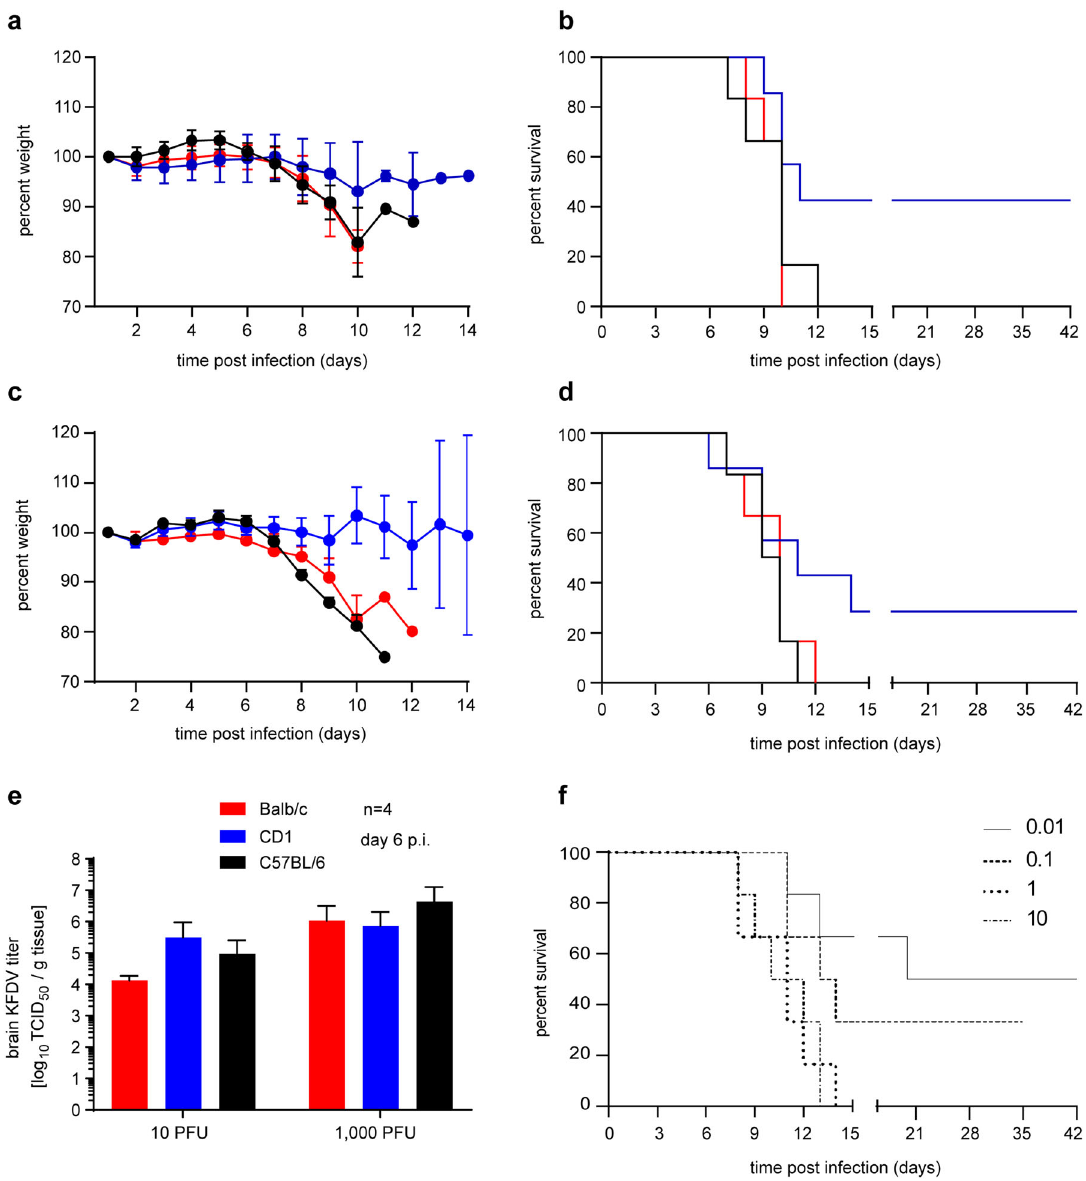
Fig. 2 KFDV infection in immunocompetent mouse strains. Female BALB/c, C57BL/6 and CD1 mice ( n = 10 per group) were inoculated intraperitoneally (IP) with either 10 or 1000 PFU of KFDV. On 6 dpi, 4 mice from each group were euthanized for sample collection. Brain tissue was homogenized and analyzed for infectious titers by a TCID 50 assay. Mice were monitored over 42 days for clinical signs. Weight was recorded daily for 14 days and the change in weight is shown as a percentage of the starting weight. a Weight curve (10 PFU of KFDV). b Survival curve (10 PFU of KFDV). c Weight curve (1000 PFU of KFDV). d Survival curve (1000 PFU of KFDV). e KFDV infectious titers in brain tissue. f Determination of the median lethal dose (LD 50 ). Female BALB/c mice ( n = 6 per group) were inoculated IP with either 0.01, 0.1, 1, and 10 PFU of KFDV and monitored over 42 days. Error bars represent the standard deviation. Statistical signi fi cance for survival curves was analyzed using the Mantel = Cox test and for brain titers and body weights using unpaired T tests both in Prism 7 (GraphPad). No signi fi cant differences were